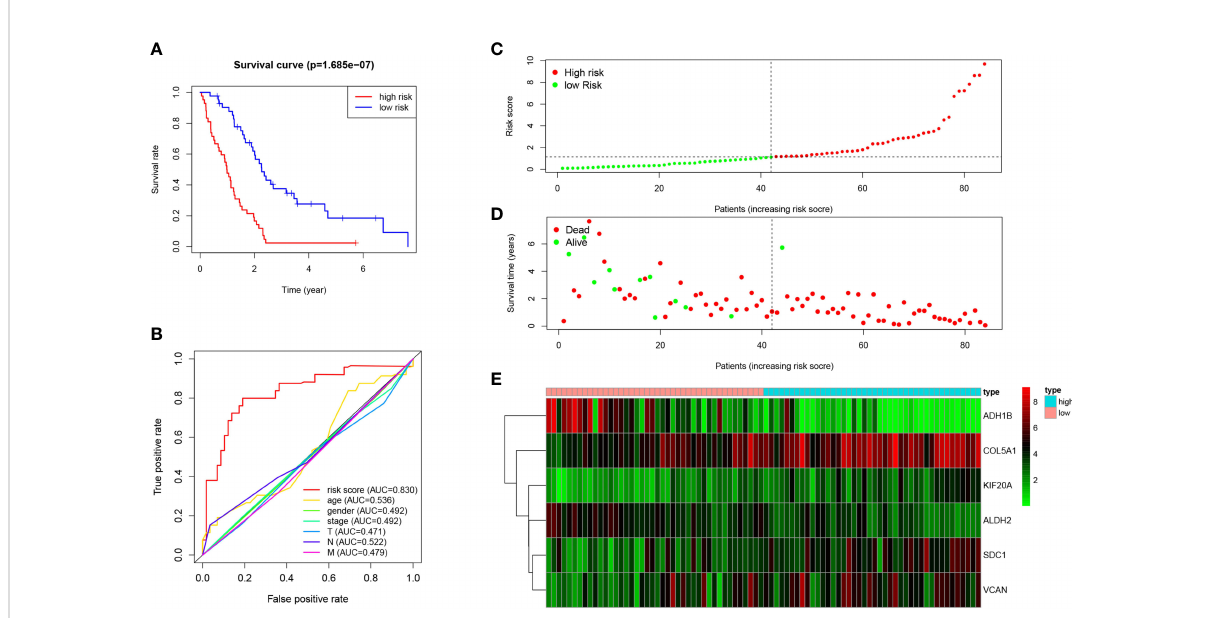
FIGURE 5 Prognosis of high-risk and low-risk MPM cases. (A) K-M analysis of MPM cases is strati fi ed by median risk. High risk scores are associated with general poor survival. (B) Multi-index ROC curve of risk score and other indicators. (C) Risk score distribution of low-risk (green) and high-risk (red) in MPM cases. (D) Scatter plot of survival status of MPM cases in. Red dots (dead); green dots (alive). (E) Expression of risk genes in the high-risk (blue) and low-risk (pink) of the OS model.